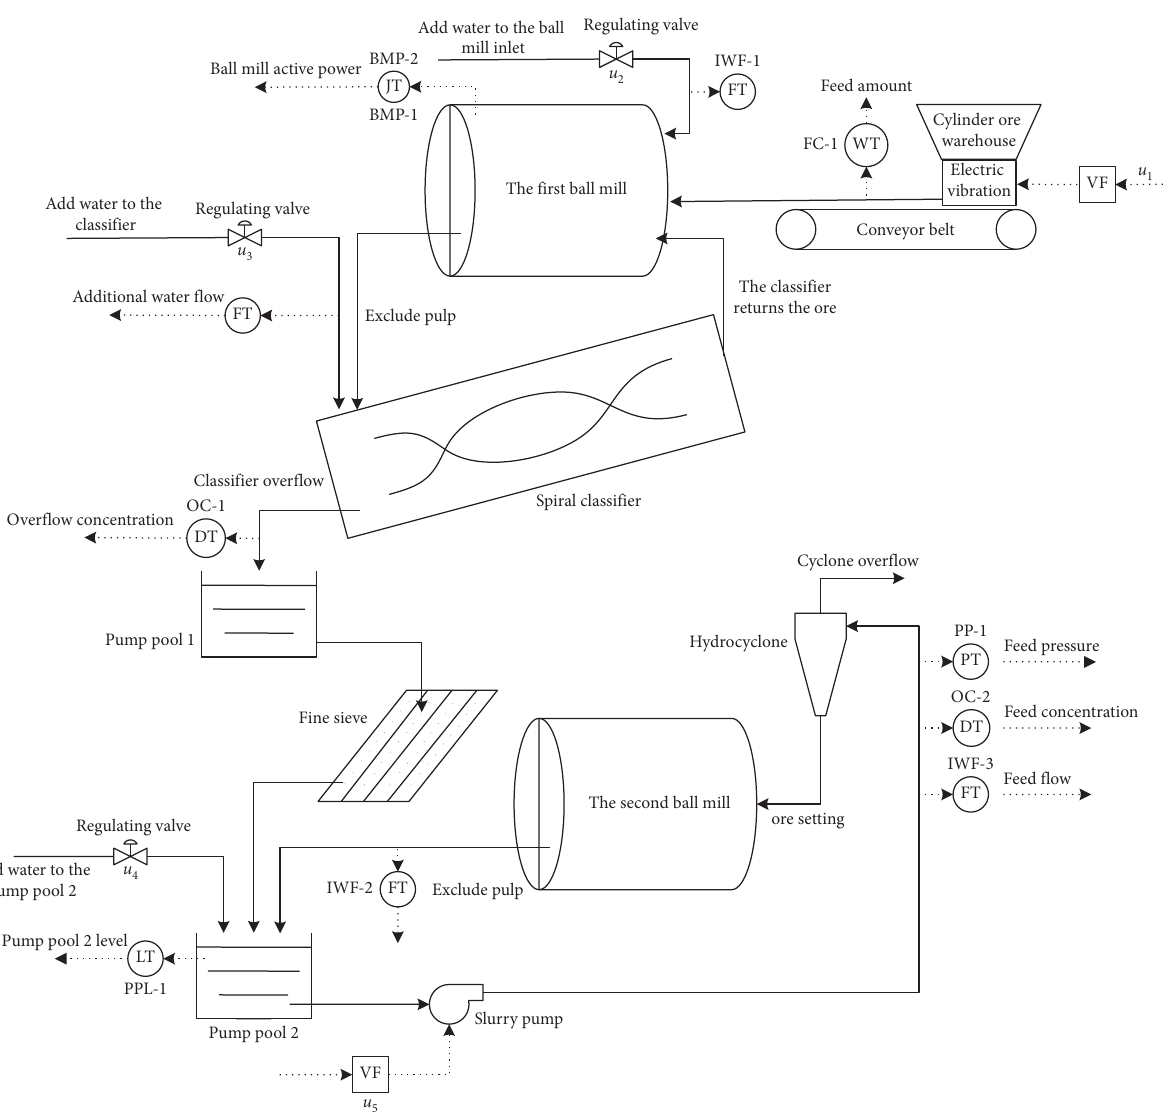
Figure 6: Schematic diagram of grinding and classification